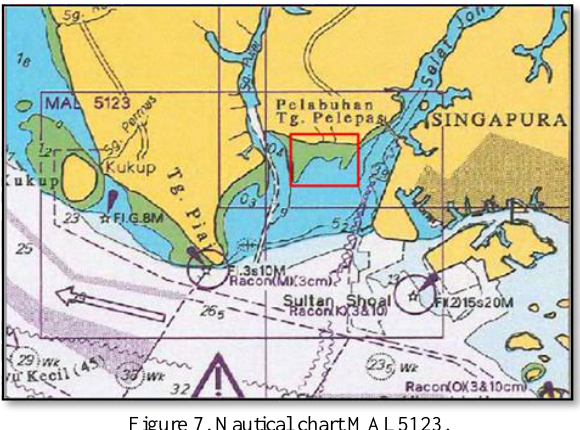
Figure 7. Nautical chart